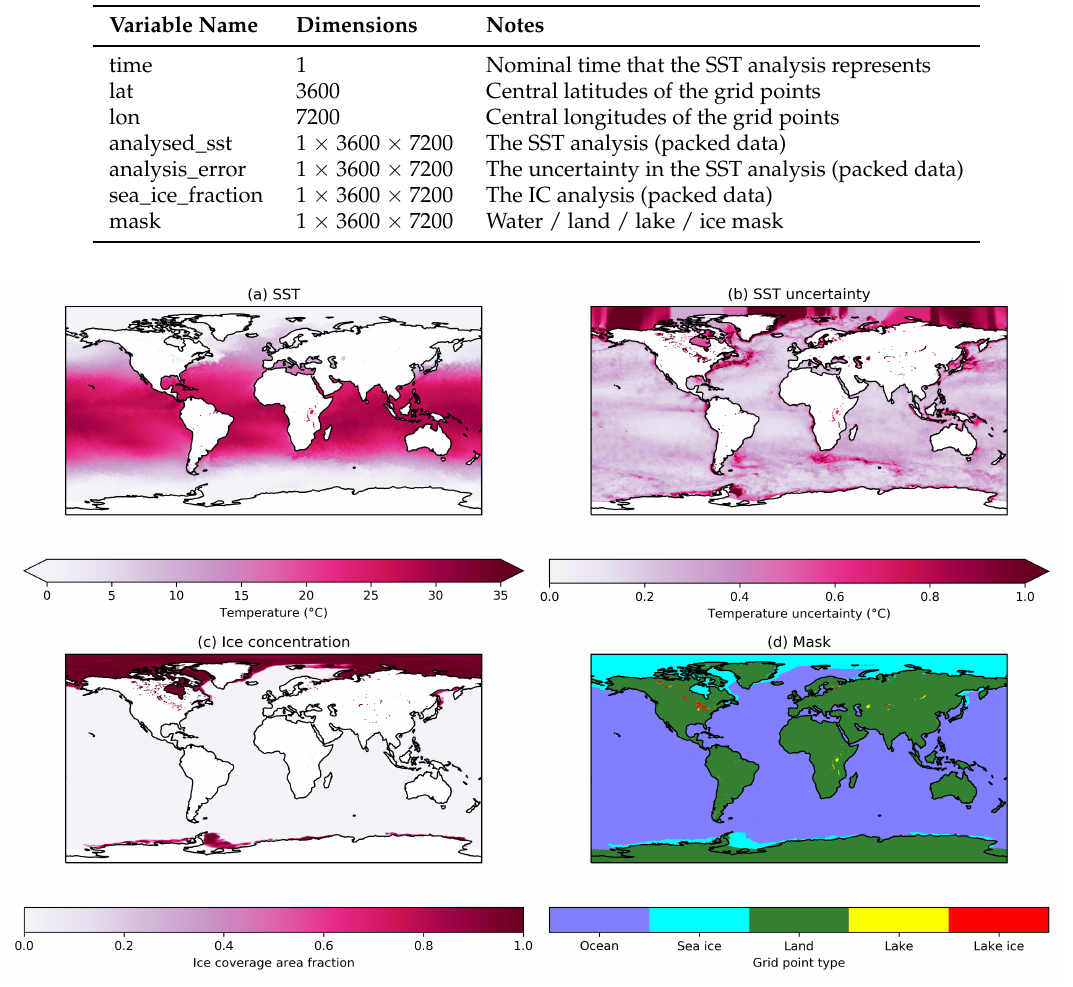
Figure 10. Example outputs from the OSTIA system for 1 February